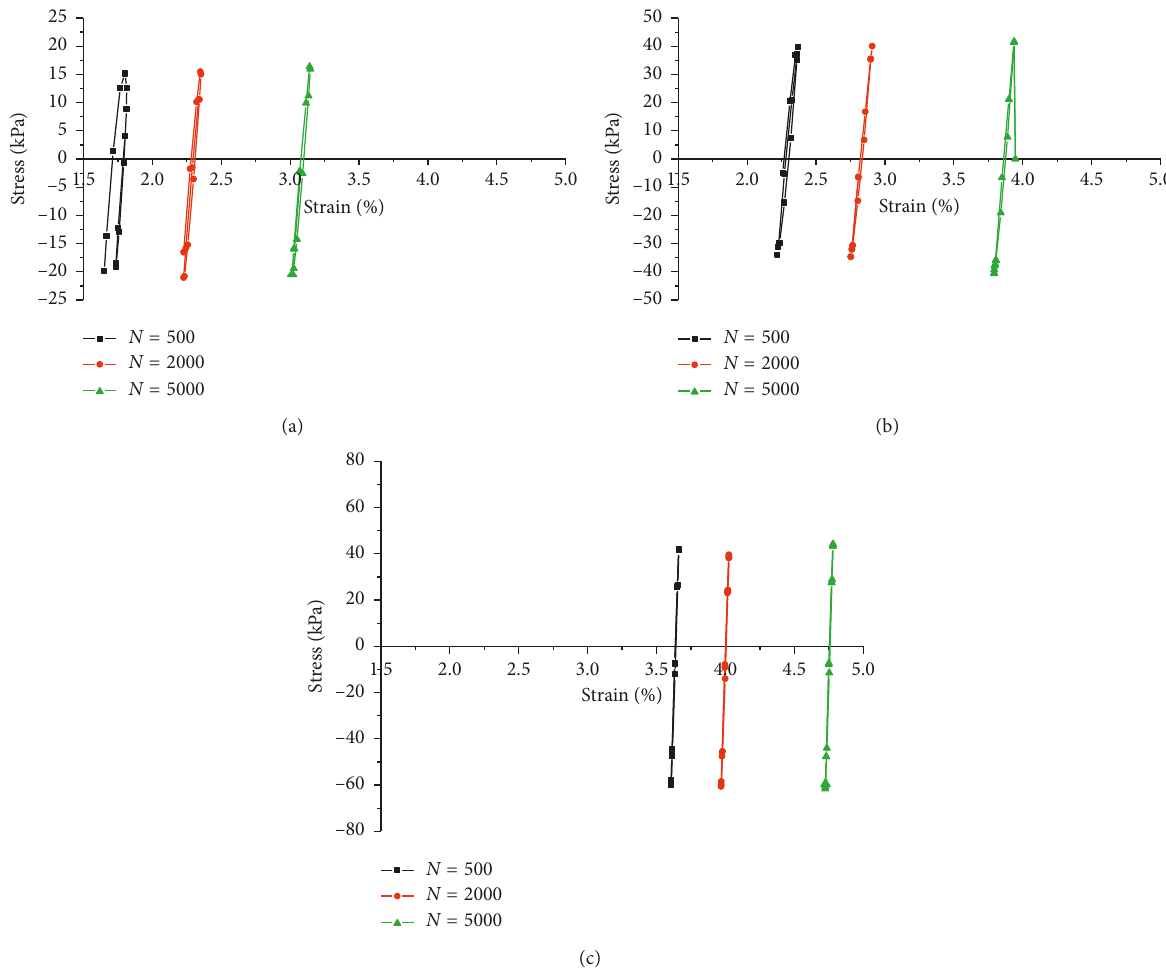
Figure 10: Hysteresis curves of Tianjin clays: (a) CSR � 0.1; (b) CSR � 0.2; (c) CSR �